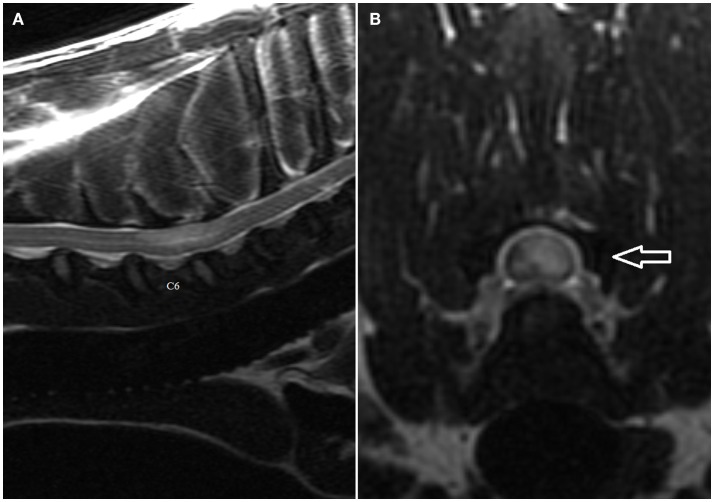
(A,B) Sagittal (A) and transverse (B) T2-weighted magnetic resonance images of the cervical spine of the English Bull Terrier shown in Video S1 in Supplementary Material. Note the intramedullary hyperintensity located above the C6 and the cranial half of C7 vertebral bodies. The spinal cord is swollen (Figure 2A). Note left-sided spinal cord intramedullary hyperintensity (arrow). There are no signal changes or extraneous material in the epidural space (Figure 2B).